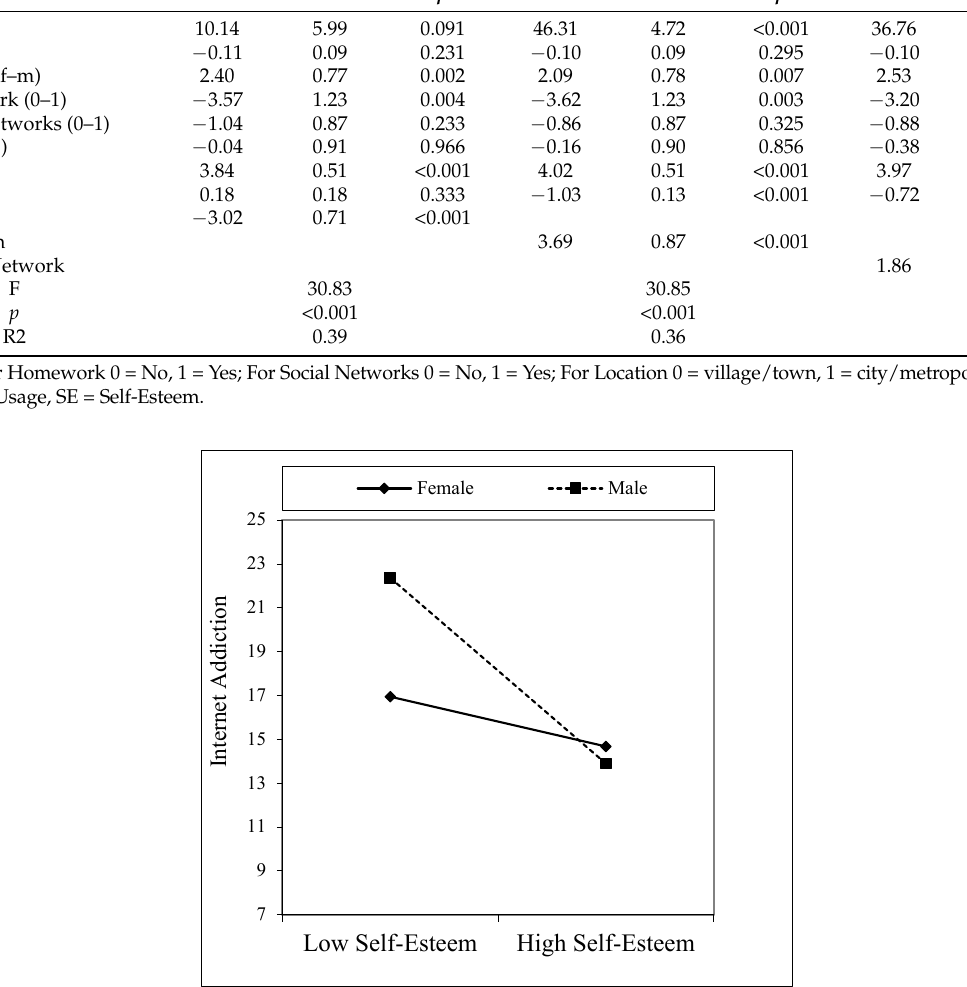
Figure 2. Interaction effect of self-esteem and gender on internet addiction.